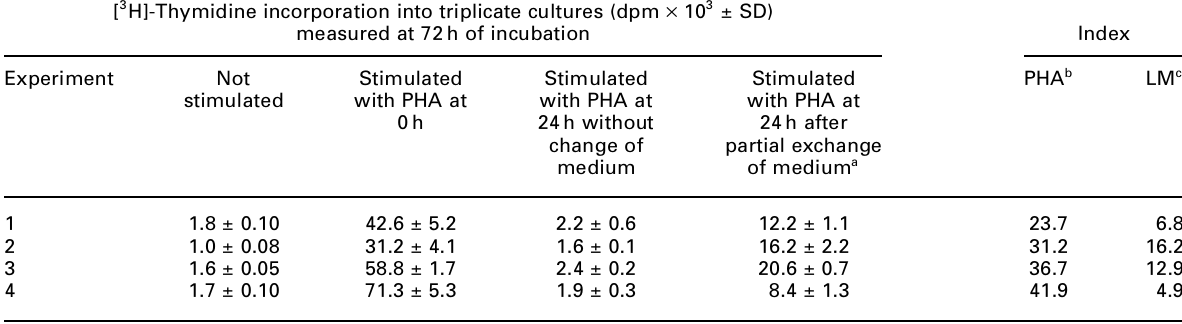
Table 1. Effects of partial exchange of medium in cultures stimulated with PHA at 24h of incubation [ 3 H]-Thymidine incorporation into triplicate cultures (dpm ´ 10 3 ± SD) measured at 72h of incubation Experiment